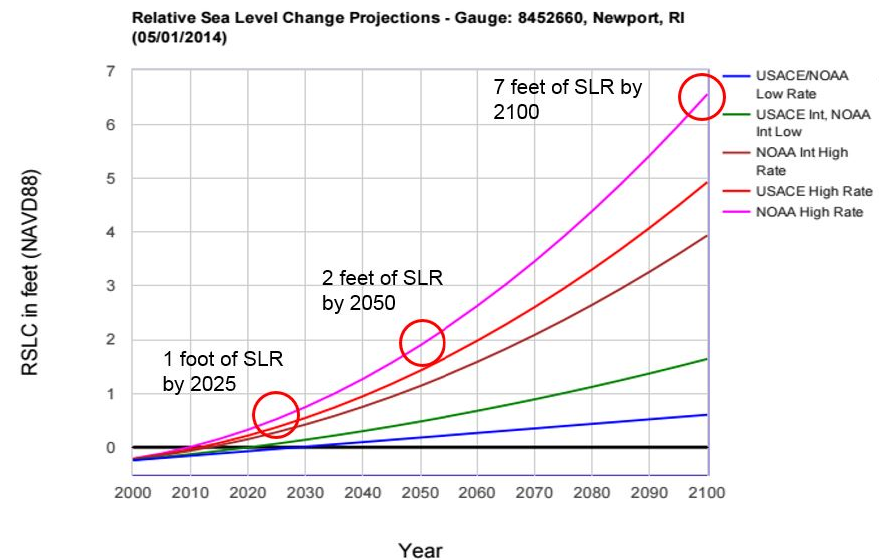
Figure 4. Sea level change projections for the southern coast of Rhode Island [3]. USACE, US Army Corps of Engineers; NOAA, National Oceanic and Atmospheric Administration.